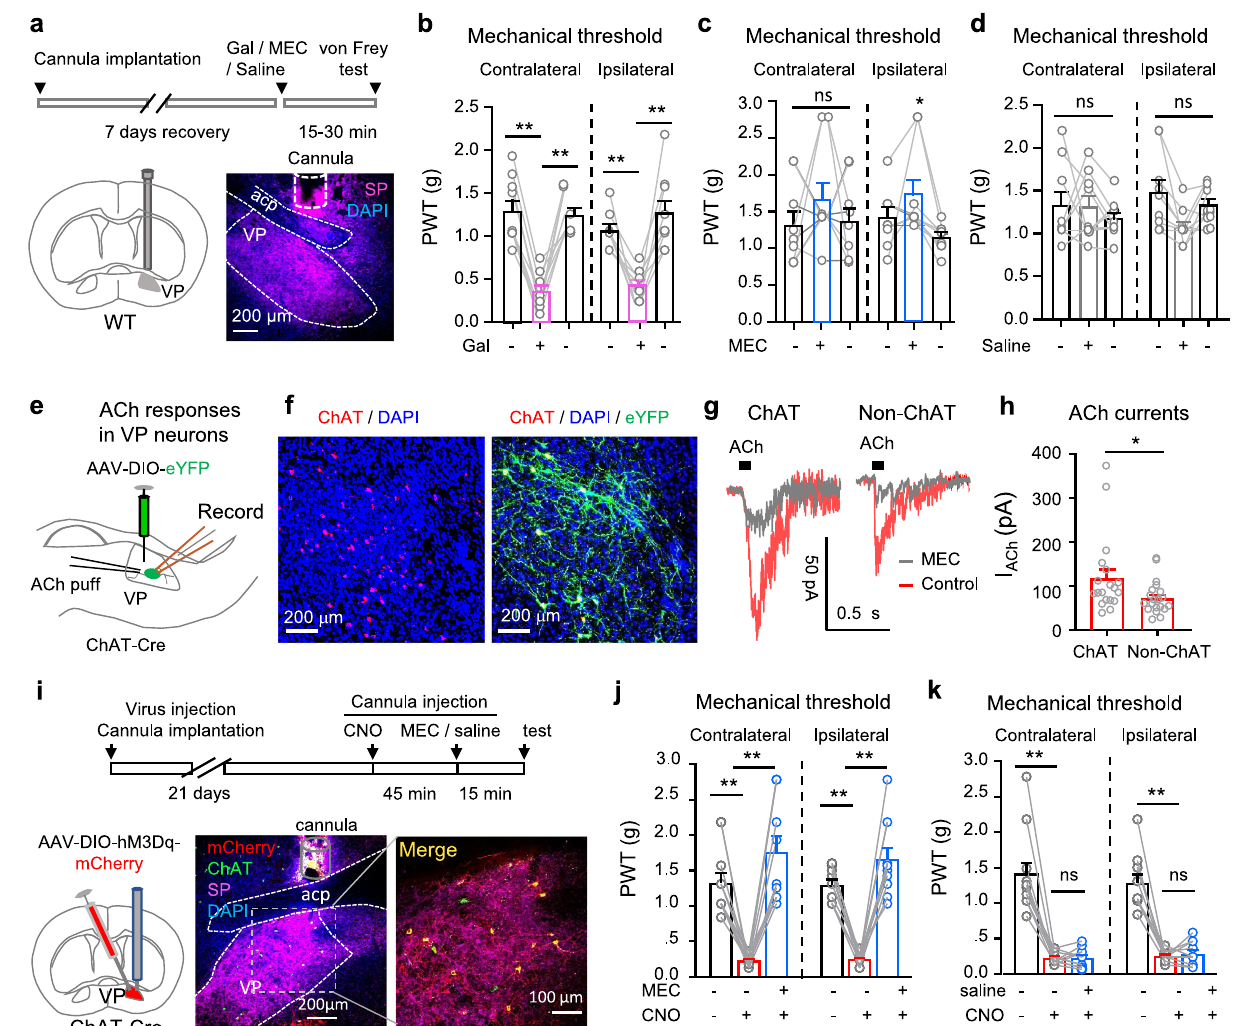
Fig. 1 | The VP ChAT circuit regulates the mechanical threshold. a Galantamine (Gal, 10 μ M), mecamylamine (MEC, 10 μ M), and saline were microinjected into the right VP through a cannula. A representative image of substance P (SP, purple) antibody-stained coronal brain section among nine repeats. b ‒ d Mechanical paw withdrawal thresholds (PWT) on both hind paws before (baseline), 15 – 30min and 24h after injection of Gal ( b ), MEC ( c ), and saline ( d ) into the VP ( n =9 mice). b Contralateral: F (1.167, 9.338) = 29.45, P <0.001; t =6.83, df=8, P <0 001, Gal vs baseline. Ipsilateral: F (1.626, 13.00) =19.56, P <0.001; t =5.99, df=8, P <0 001, Ga1 vs baseline. c Contralateral: F (1.895, 15.16) =0.87, P =0.44. Ipsilateral: F (1.384,11.07) =5.48, P =0.02; t =3.31, df=8, P =0.01, MEC vs recovery. d Contralateral: F (1.336, 10.69) =0.80, P =0.48. Ipsilateral: F (1.620, 12.96) =0.88. P =0.45. e Whole-cell patch- clamp recordings were performed from virally labeled VP ChATneurons to record responses to acetylcholine (ACh). f Representative images among fi ve sets of